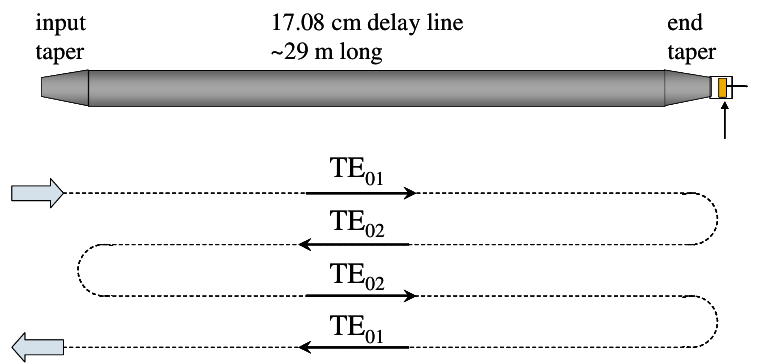
FIG. 15. (Color) Dual-moded delay lines.